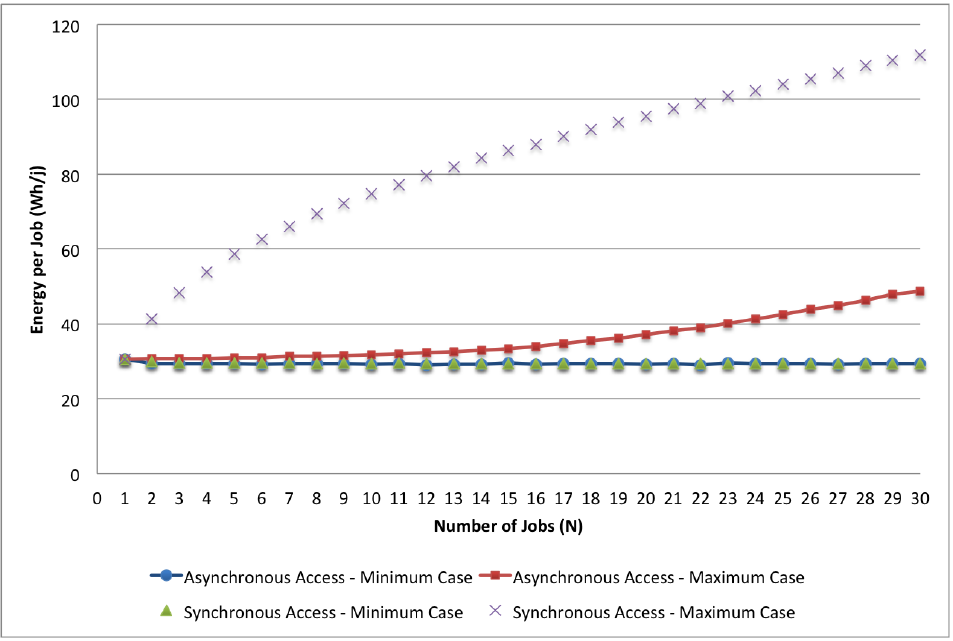
Figure 13. Bounds on energy per job.